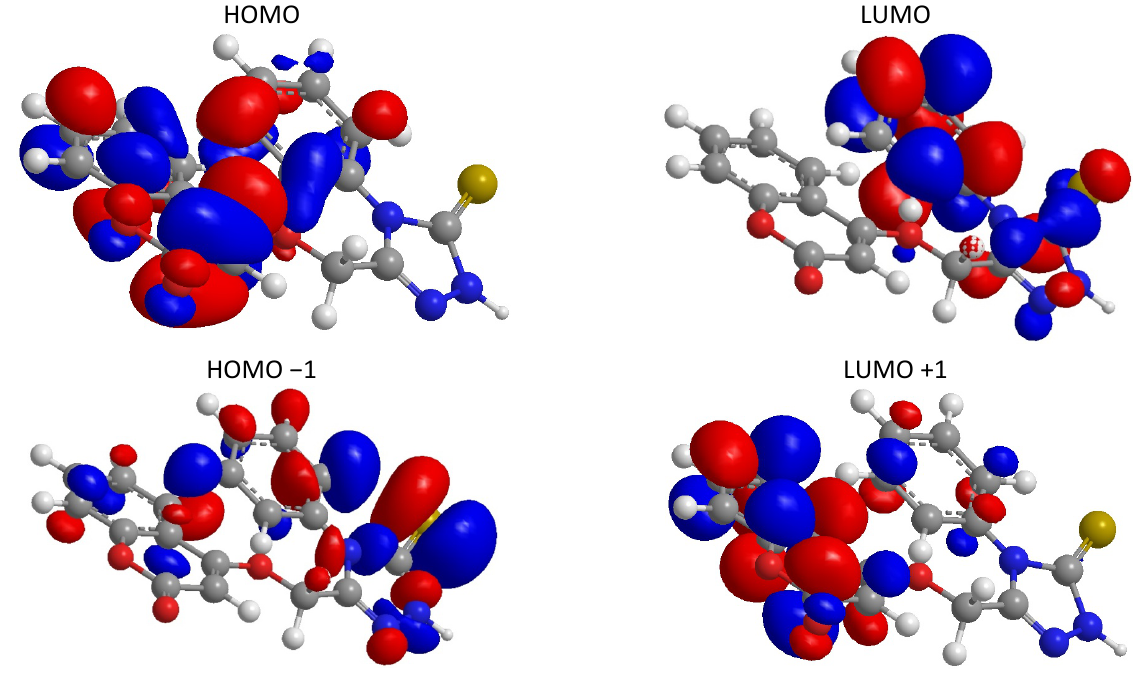
Figure 2. HOMO, LUMO, HOMO − 1 and LUMO +1 orbitals of 5 . HOMO